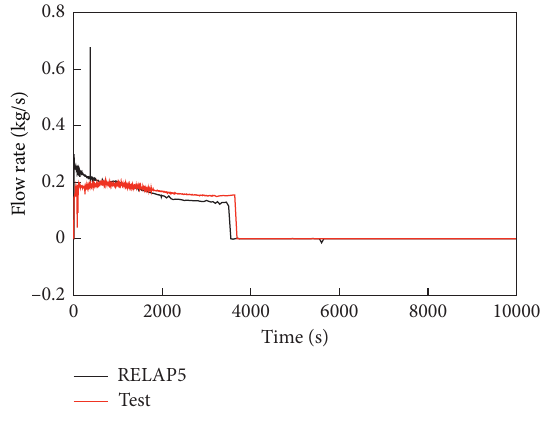
Figure 4: Flow rate of the make-up